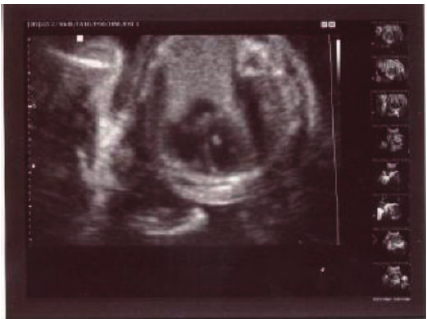
Figure 1: Echogenic cardiac focus in left ventricle.